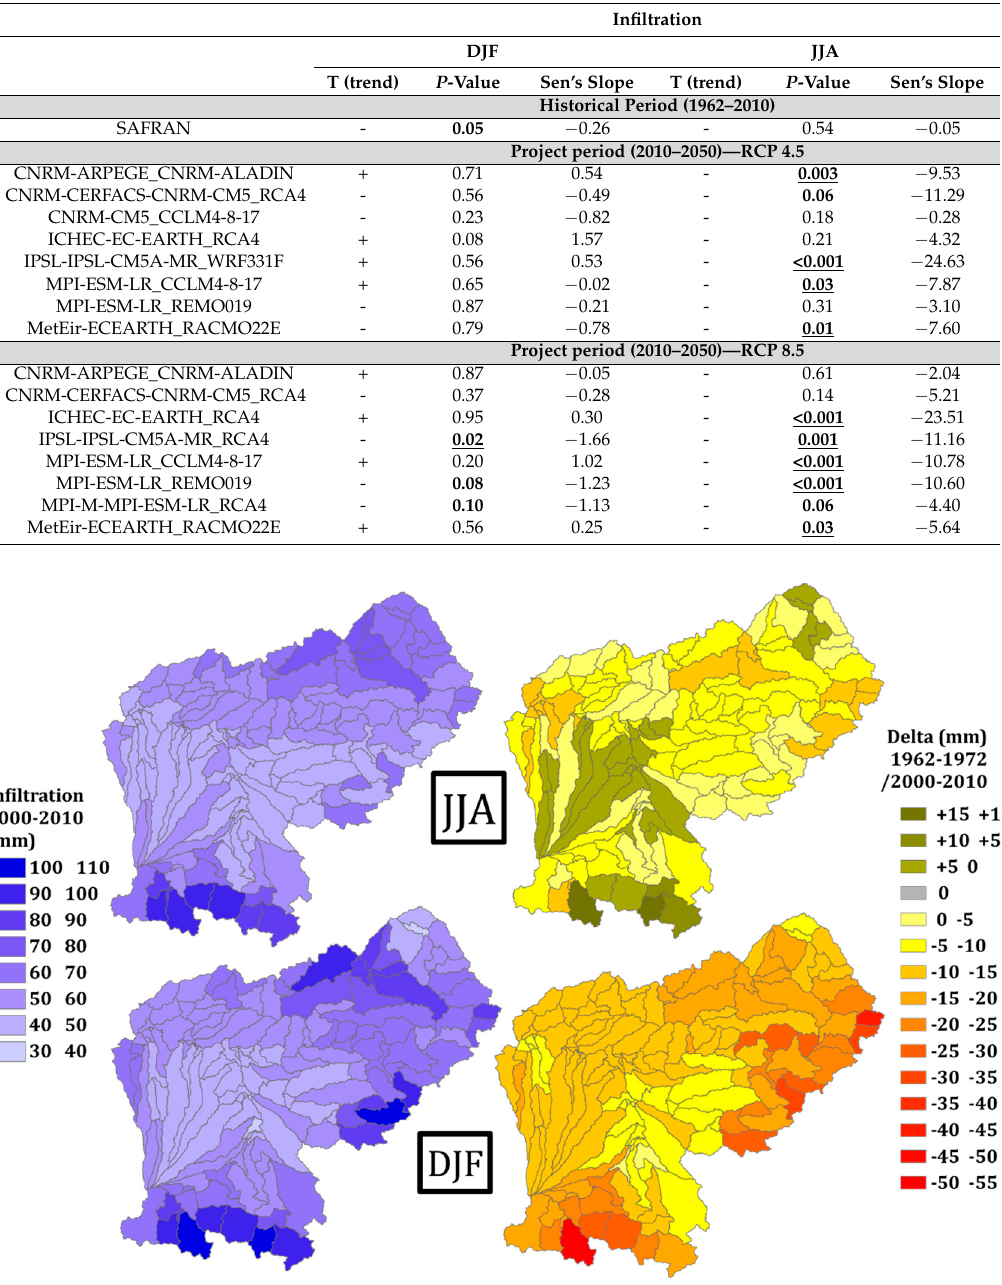
Table 10. Trend in subsurface flow over winter (DJF) and summer (JJA) seasons at watershed scale, for SAFRAN (historical period) and climatic ensemble (projected period). Bold numbers are significant trend considering α = 0.1 and underlined numbers considering α = 0.05. Subsurface flow DJF